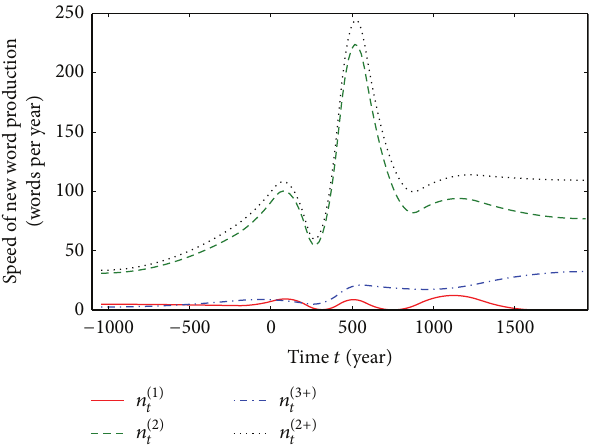
Figure 4: The quantitative trend of the polysyllablization degree index